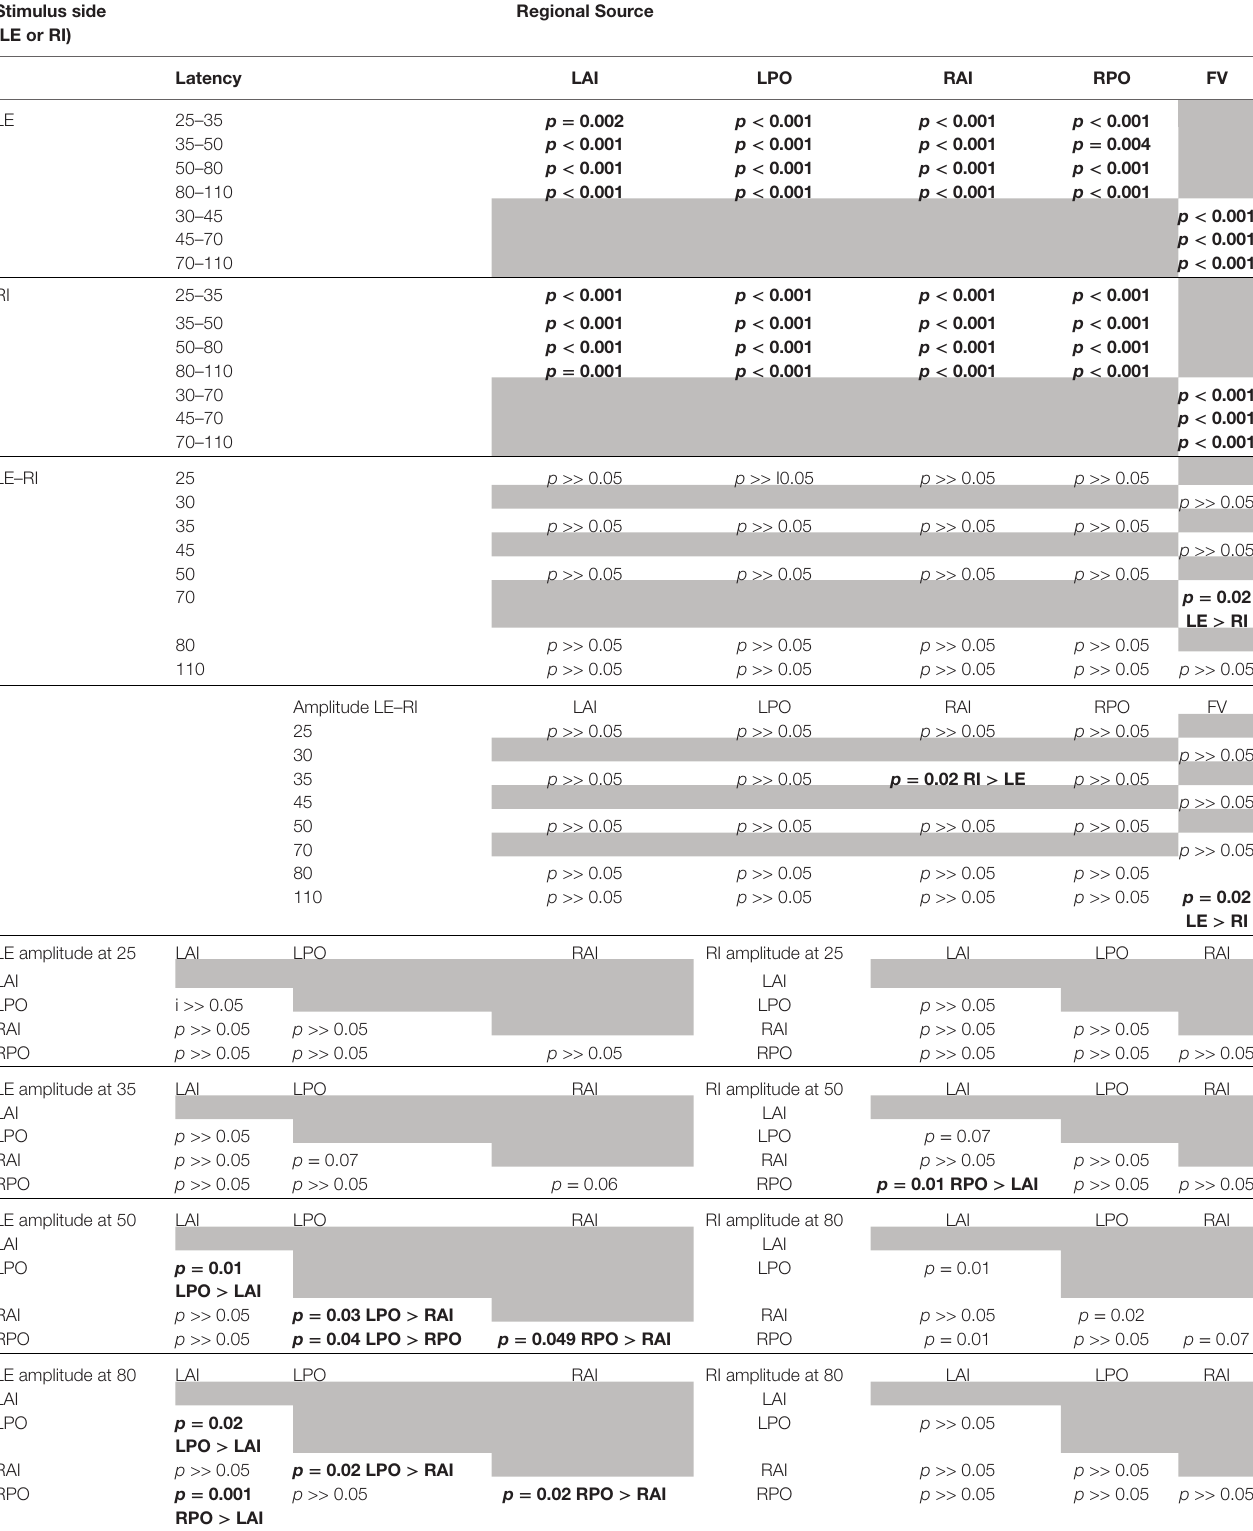
TaBle 2 | Comparison of evoked potentials for regional sources right anterior insula (RAI) and left anterior insula (LAI), right posterior operculum (RPO) and left posterior operculum (LPO) and frontal regions (FV) for bipolar galvanic stimulation with cathode left (LE) or right (RI) at time intervals 25, 35, 50, 80, and 110 for RAI, LAI, RPO and LPO regions and 30, 45, 70, and 110 ms for frontal